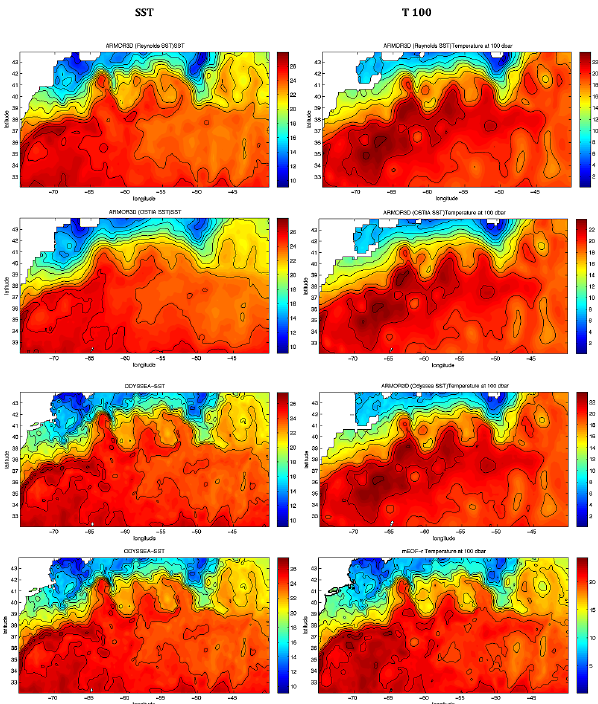
Fig. 7. SST (left panels) and temperature at 100m (right panels) from the four reconstruction methods selected (from top to bottom): ARMOR3D using Reynolds L4 SST as input, ARMOR3D using OSTIA L4 SST as input, ARMOR3D using ODYSSEA L4 SST as input, and mEOF-r( T - S -SH) SST-SSH .